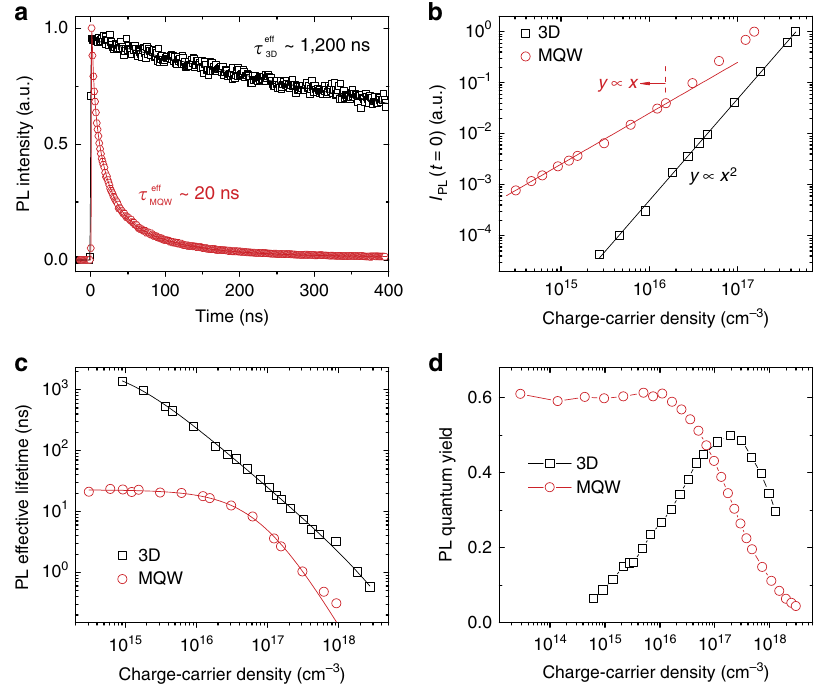
Figure 3 | Bimolecular emission in three-dimensional (3D) perovskites versus excitonic emission in perovskite multi-quantum wells (MQWs) ( a ) Time-resolved photoluminescence (TRPL) decay transients measured at 812 ± 60nm for 3D perovskite and 782 ± 60nm for perovskite MQW films following excitation at 650nm (1KHz, 100fs, around 0.01 m Jcm (cid:2) 2 ). The solid lines are exponential fits of the PL decay transients. ( b ) Photon-injected carrier density dependence of the initial time PL intensity ( I PL (0)) following excitation at 650nm (1KHz, 100fs). The quadratic dependence indicates that